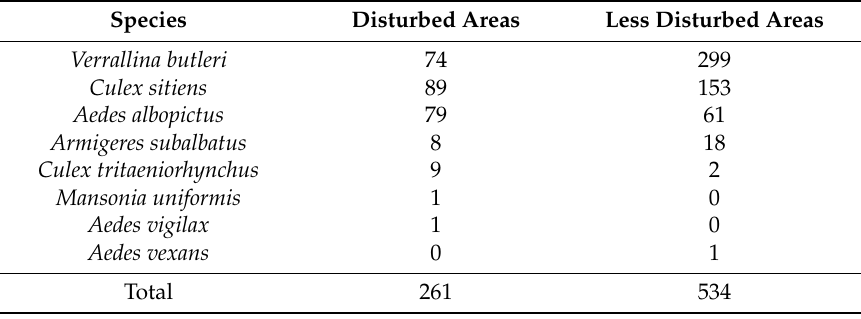
Table 1. Number of individuals per each mosquito species collected in disturbed and less disturbed areas of Merbok mangrove forest. Species Disturbed Areas Less Disturbed